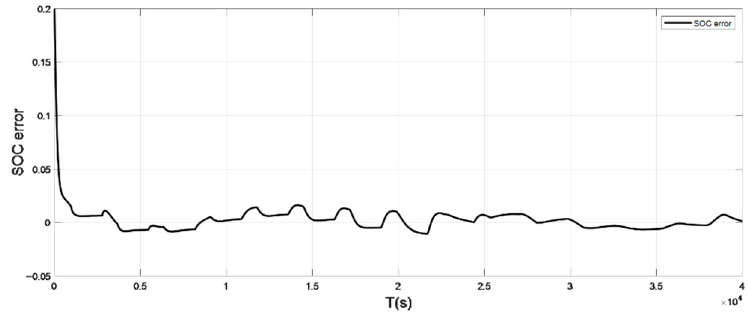
Figure 16. Comparison of the SOC real value and estimated value under constant current dis- charge (high temperature: 50 °C).